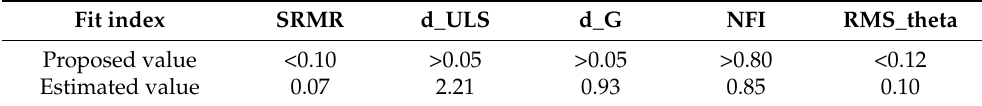
Table 7. Fit indices of the structural model.